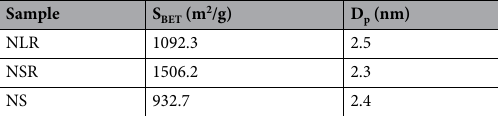
Table 1. The property characterization of NLR, NSR and NS.